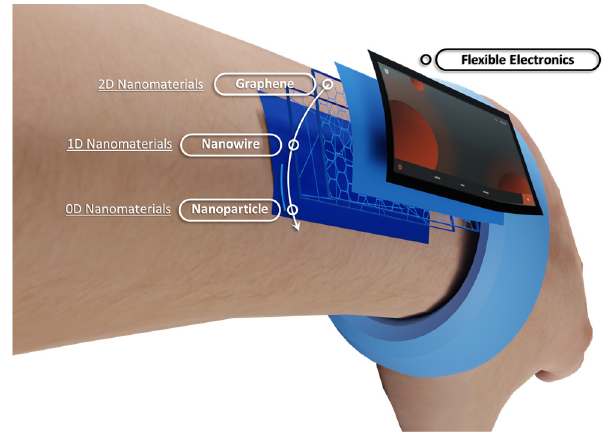
Figure 1. The application of low-dimensional materials in flexible electronics.